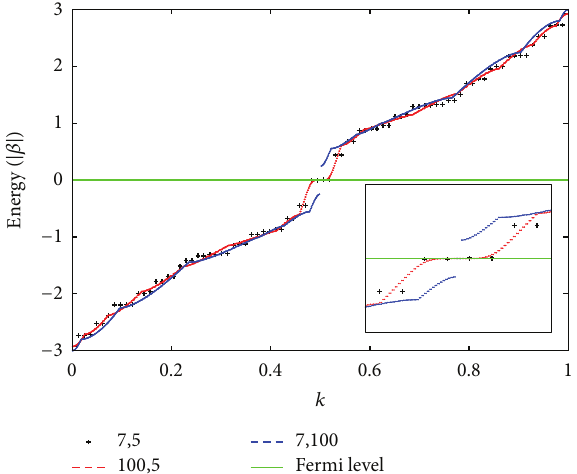
Figure 2: H¨uckel orbital energies for the nanotube (6 5) , where |𝛽| is the energy unit and 𝑘 is the normalized orbital number.